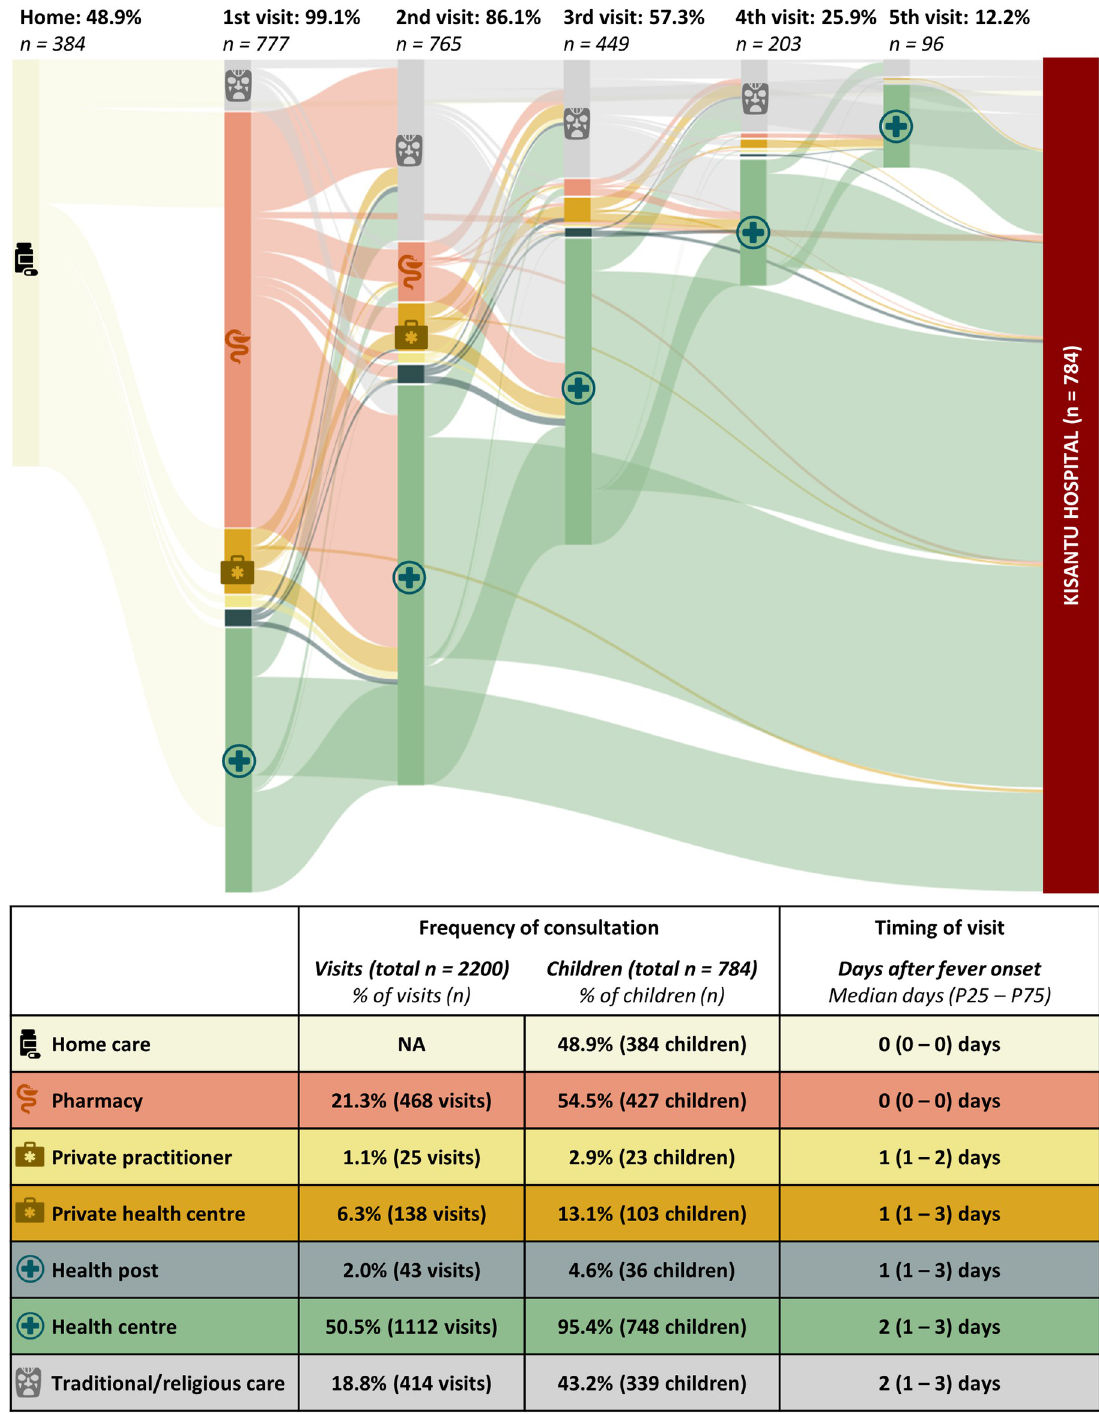
Fig 4. Administration of home care and consultation of healthcare providers before hospital admission in children under-five admitted to Kisantu hospital with severe febrile illness (784 children accounting for 2200 healthcare visits).